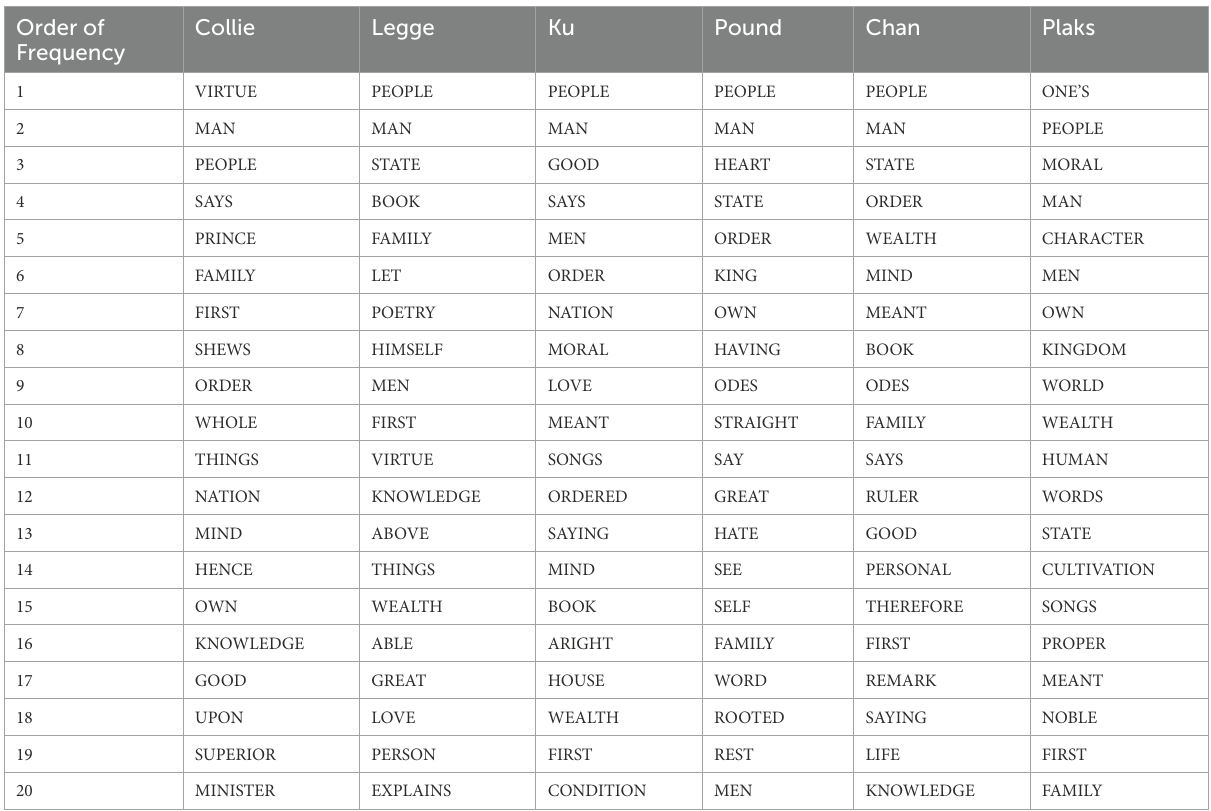
TABLE 6 Top 20 high-frequency words of the six TTs. Order of Frequency